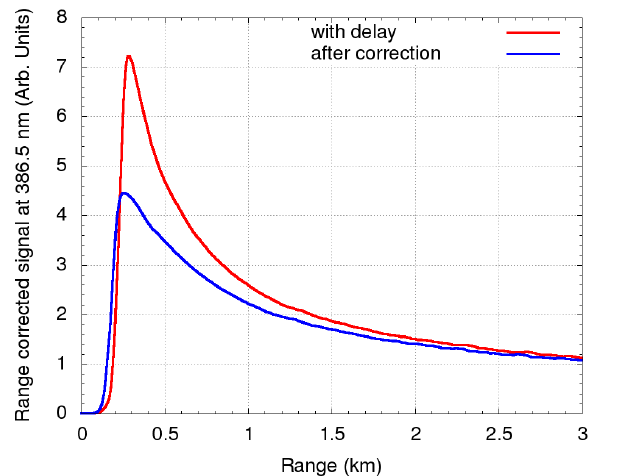
Figure 7. Range square corrected signal from the analog detection chain of the N 2 channel. The red curve represents the signal with the trigger delay. The blue curve represents the signal after trigger delay correction for